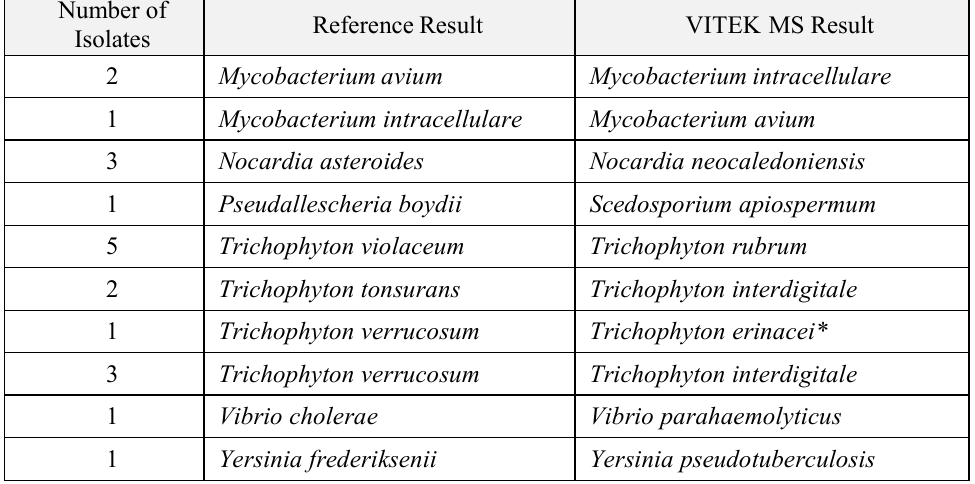
TABLE 16: Single Choice Discordants Number of